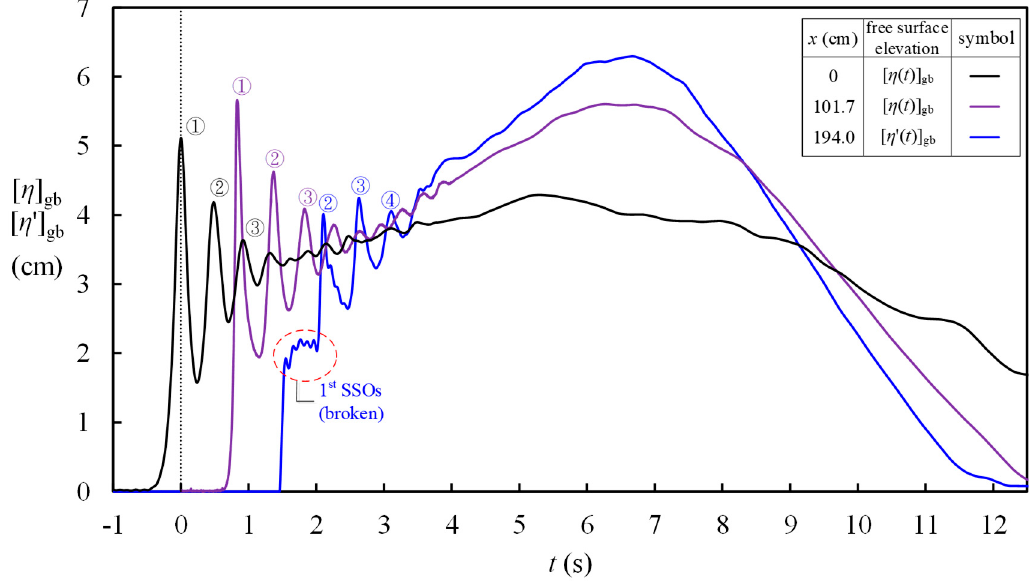
Figure 4. Time series of free surface elevations measured at three different sections between x = 0 cm and x = x SMS = 194.0 cm (i.e., specified measuring section (SMS)). Note that crests of n th leading wave measured at distinct x are marked by circled n in different colors.